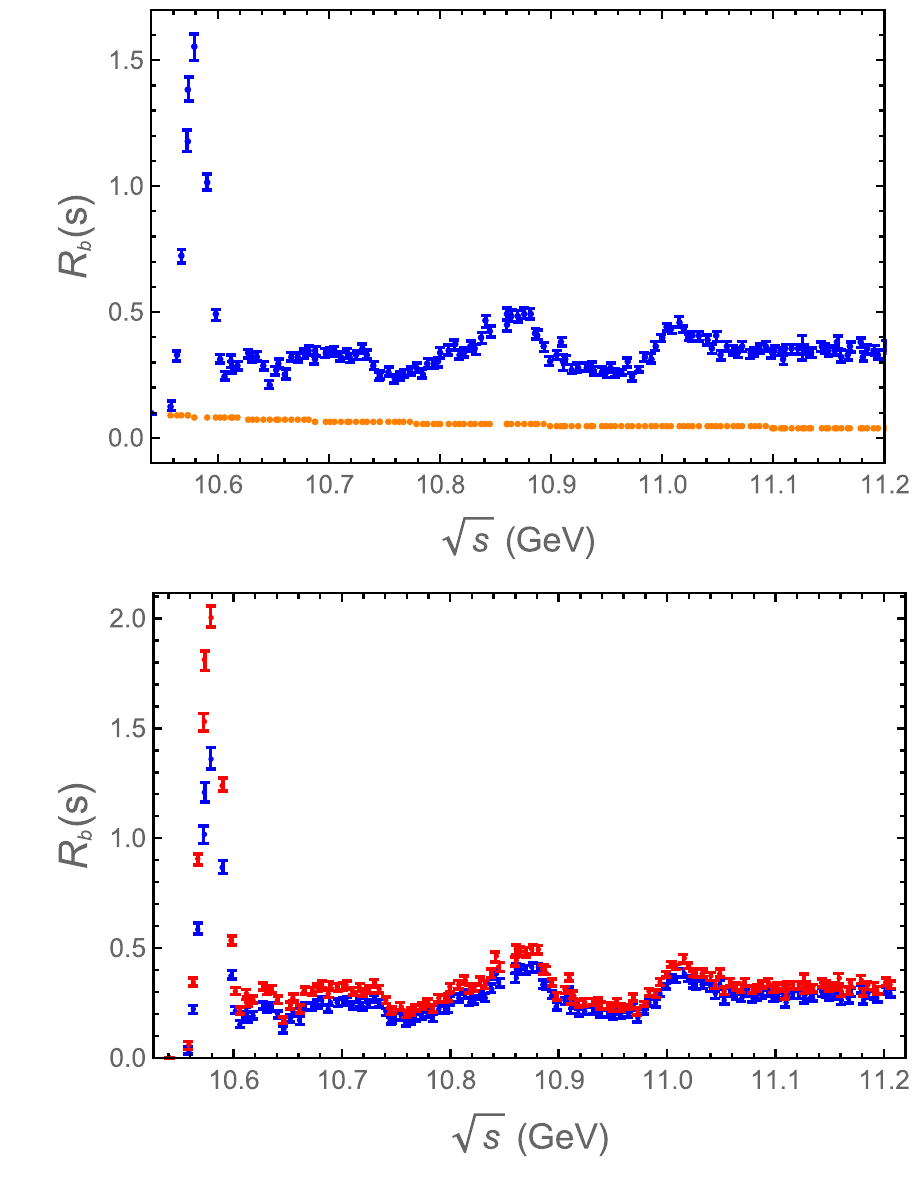
Fig. 5 Data for R b ( s ) (blue points) from the BaBar Collaboration. The orange points show the initial-state radiative tail of the first three narrow states below threshold. Both R b data and ISR tail are taken from Ref. [37]